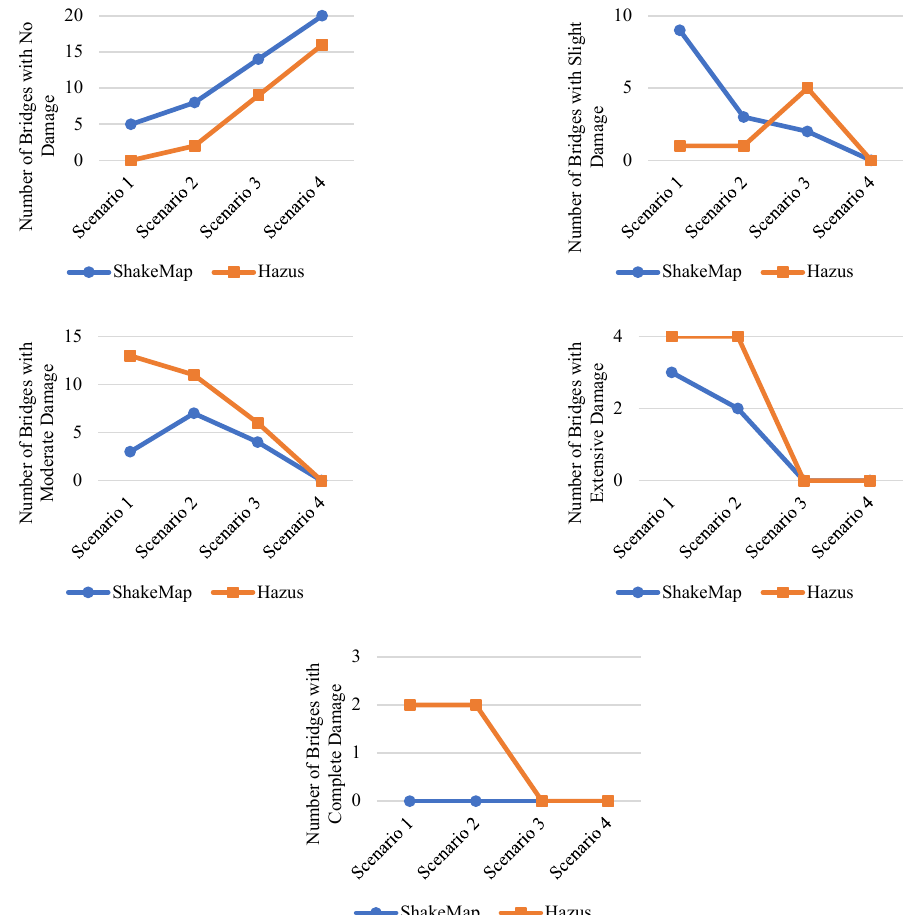
Figure 11. Comparison of estimates of number of bridges damaged based on ShakeMap and HAZUS hazard analysis.